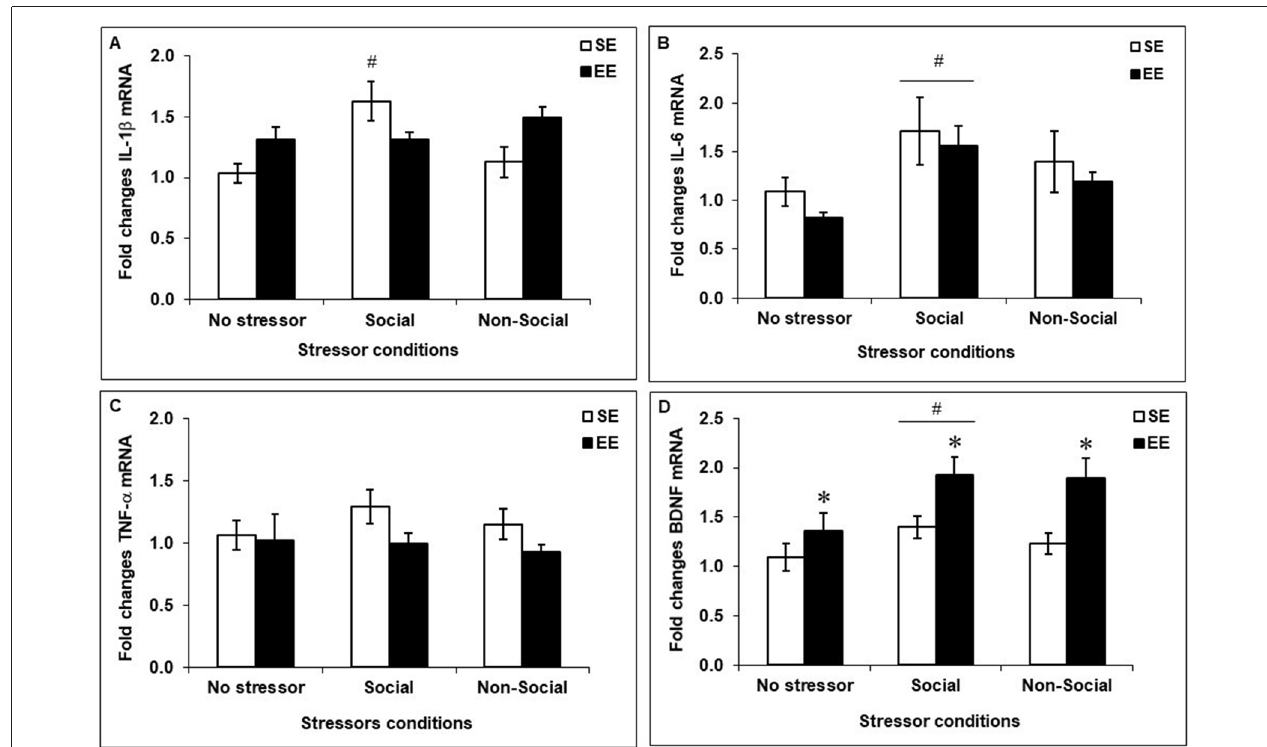
FIGURE 5 | Fold change in prefrontal mRNA expression of pro-inflammatory cytokines and BDNF assessed 90 min after the social interaction test (which acted as a Social Stressor), the elevated-plus maze (which acted as a Non-Social Stressor) or a control condition (No Stressor) among mice housed for 6 weeks in a SE or an EE. (A,B) Mice housed in SE had increased prefrontal IL-1 β and IL-6 after the Social Stressor but not the Non-Social Stressor ( # p ’s < 0.01 and 0.05, relative to mice in the No Stressor condition). Whereas the IL-1 β increases were prevented in mice housed in EE, the IL-6 expression remained elevated. (C) A main effect of Housing was observed with respect to prefrontal TNF- α expression, with the cytokine being reduced in EE mice ( p < 0.05). (D) Mice housed in EE had increased prefrontal BDNF expression compared to SE mice ( ∗ p < 0.005 relative to mice housed in SE). As well, BDNF expression was upregulated after the Social Stressor compared to the No Stressor condition ( # p < 0.05 relative to mice in the No Stressor condition). Data represents means ± SEM (SE mice/No stressor: n = 6; SE mice/Social: n = 10; SE mice/Non-Social: n = 11; EE mice/No Stressor: n = 6; EE mice/Social: n = 9; EE mice/Non-Social: n =